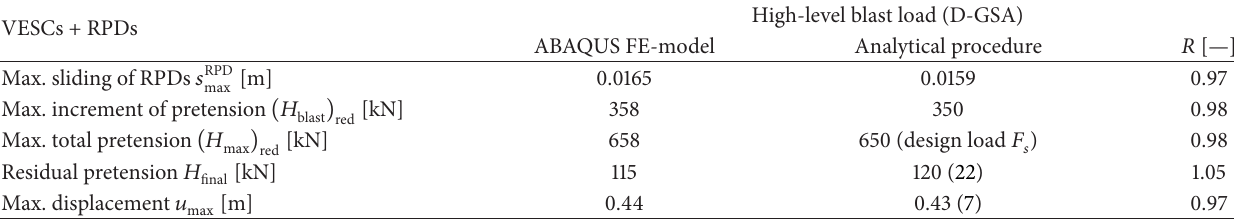
Table 6: Comparison of numerical and analytical results for the fac¸ade-module with VESCs and RPDs. VESCs +